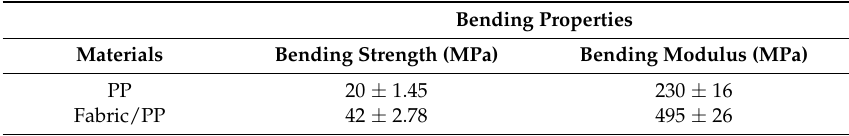
Table 2. Bending properties of polypropylene (PP) and fabric/PP